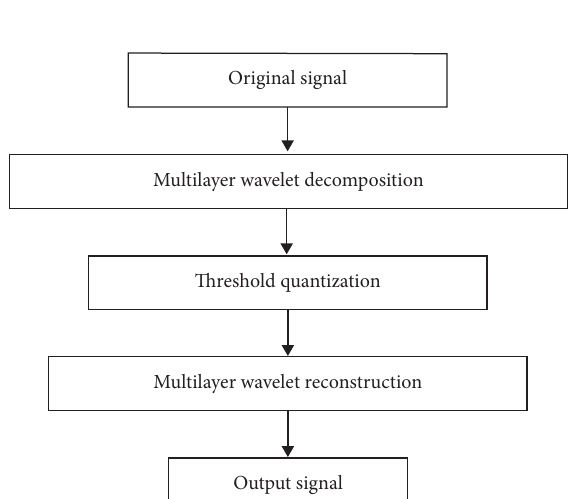
Figure 2: The flowchart of wavelet threshold denoising algorithm.